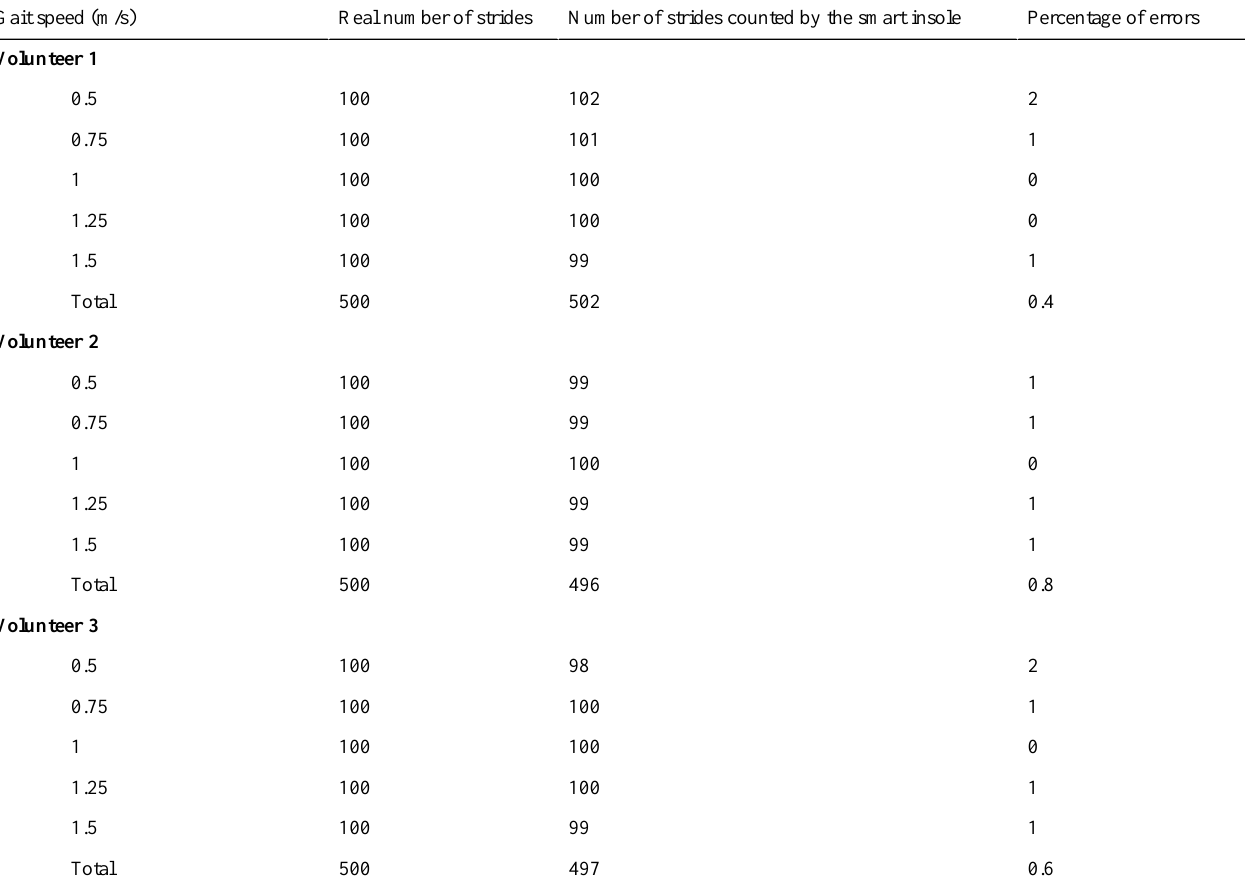
Table 1. Test of the stride detection